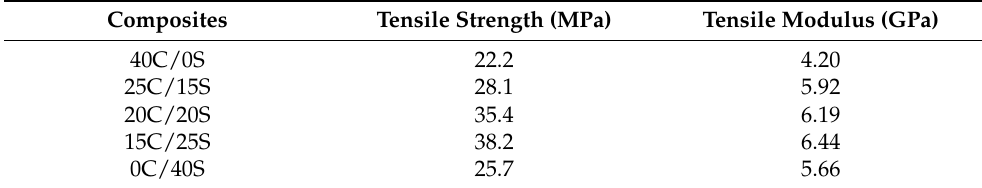
Table 4. Tensile strength